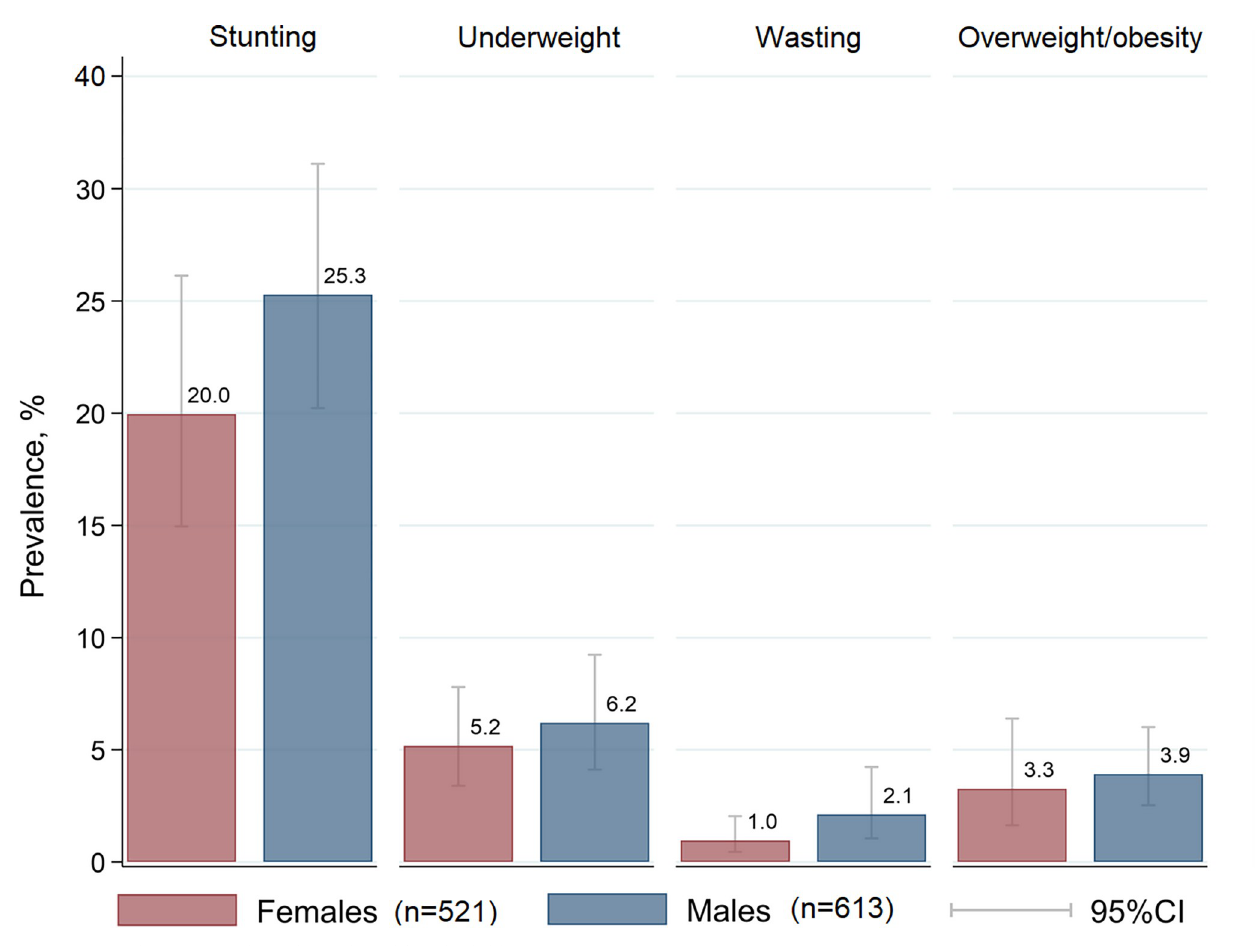
Fig 1. Nutritional status prevalence for male and female